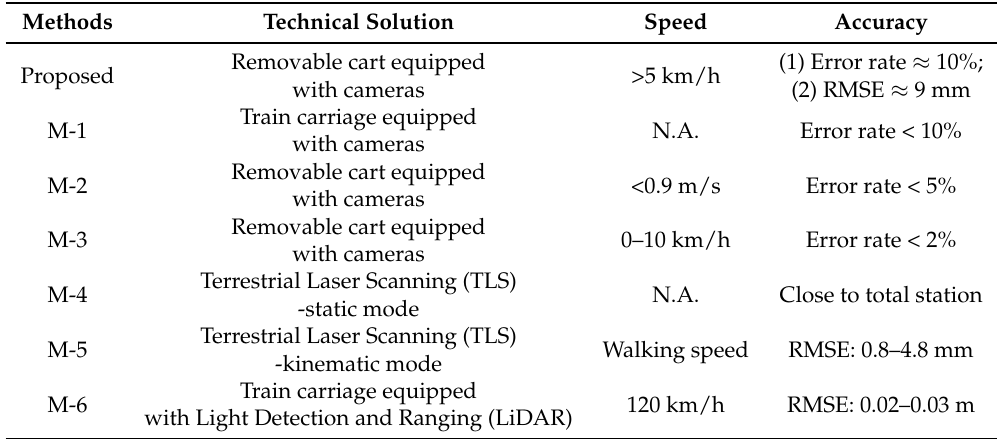
Table 5. Comparison of proposed method with state-of-the-art